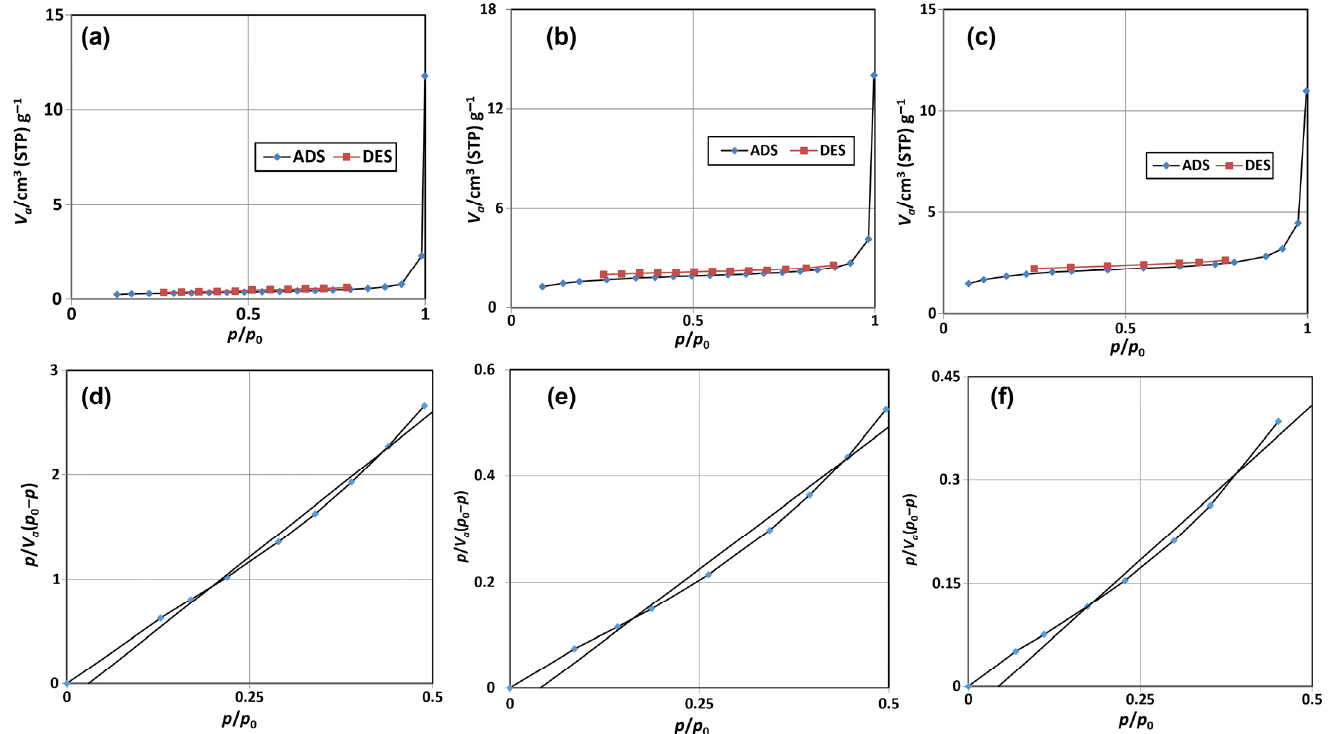
Figure 3. Comparison of N 2 adsorption/desorption isotherms ( a – c ), and BET isotherm ( d – f ) of ES-CaCO 3 NPs, RHSiO 2 NPs, and CS-SiO 2 /CaCO 3 NCs respectively.